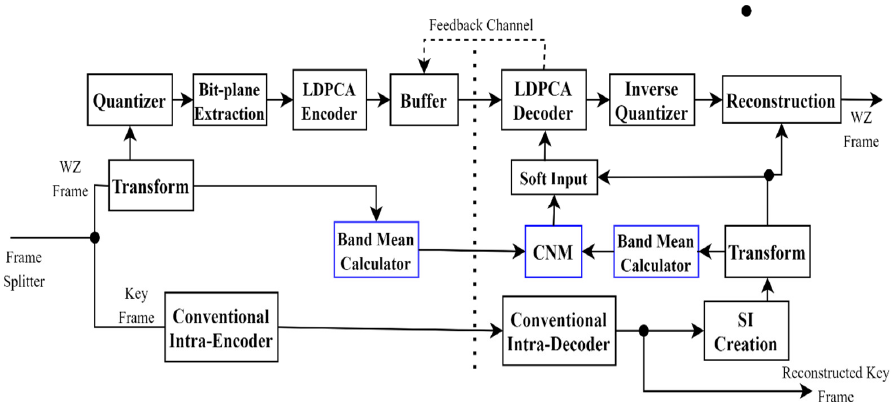
Figure 1. Proposed DVC framework with novel online correlation noise model.